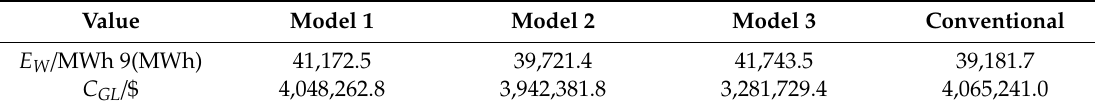
Table 7. Results of di ff erent optimization